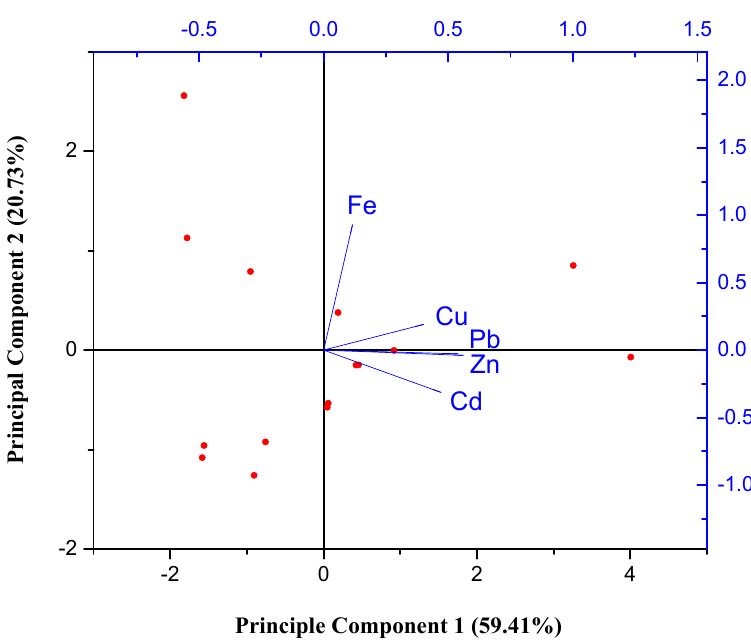
Figure 8. Principal component analysis (PCA) plot showing the loading of two components influencing variation of heavy metals in the sediments.